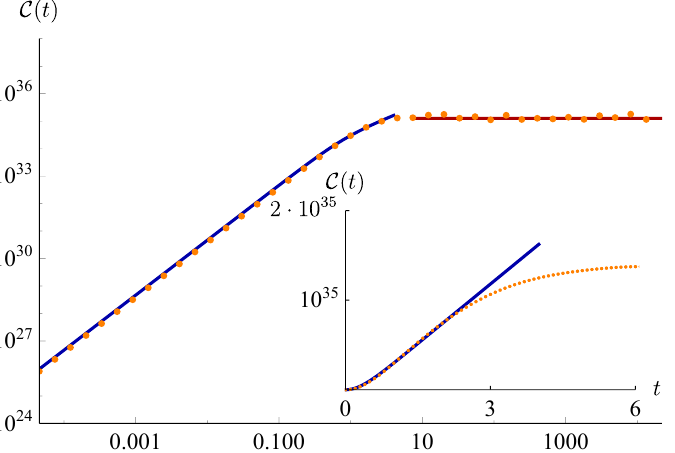
Figure 7 . The spectral complexity in the SYK model with N = 18 , q = 4 and βJ = 23 , averaged over 90 members of the ensemble. Like in the random matrix theory example, the spectral complexity grows at early times as # log cosh(# t/β ) and plateaus at late times. The inset shows the linear scaled plot around t = 0 to better emphasize the validity of the logarithmic